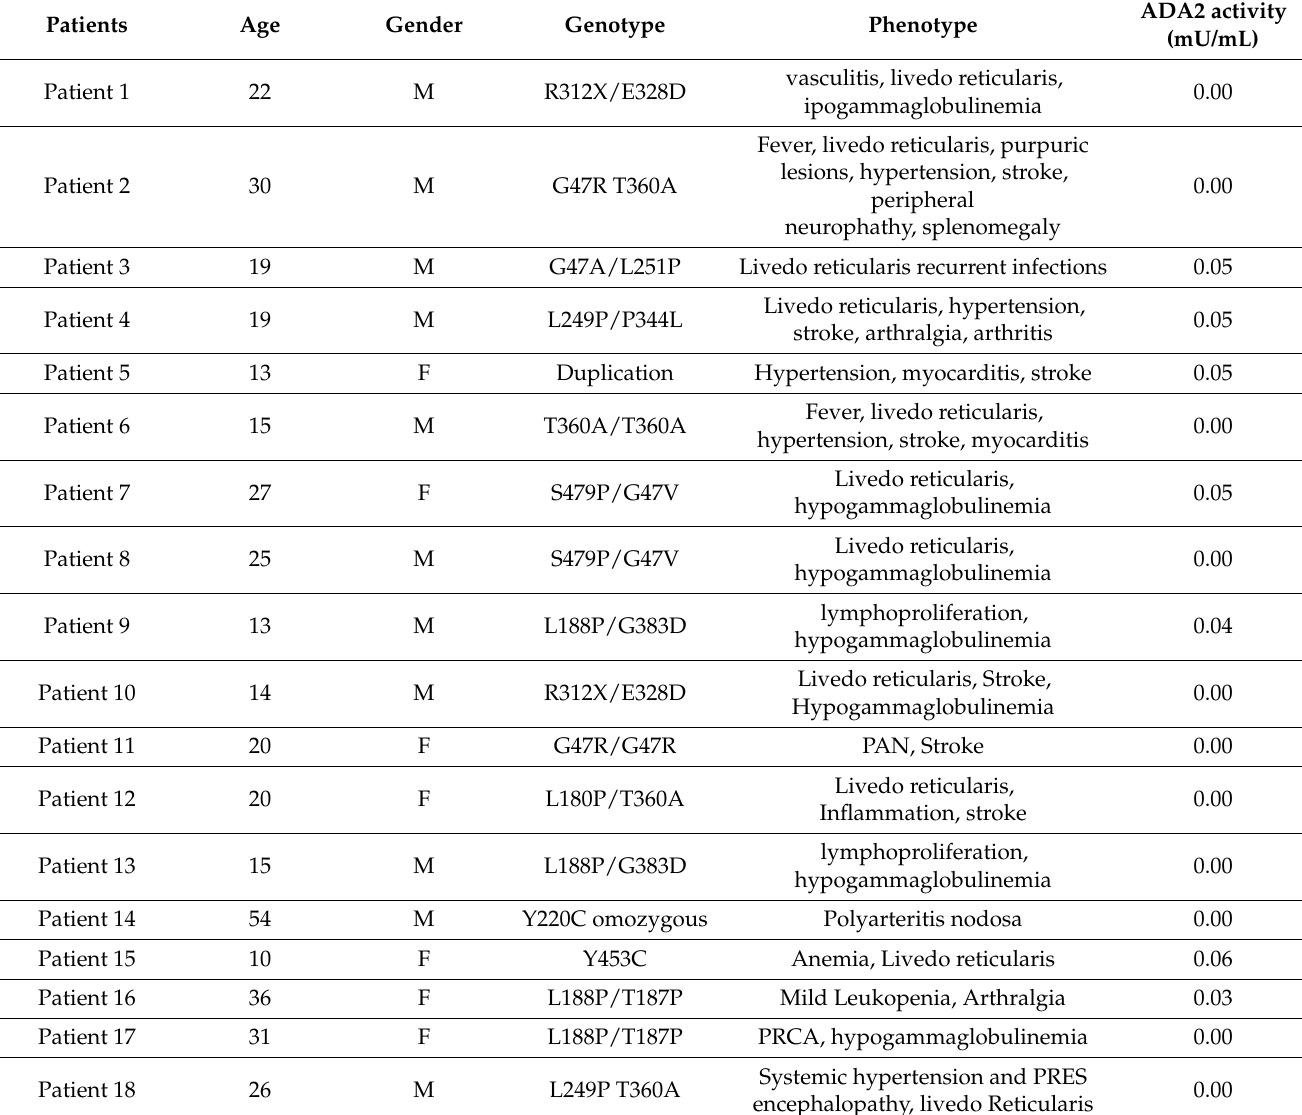
Table 1. Characteristics of patients and results of ADA2 activity (expressed in